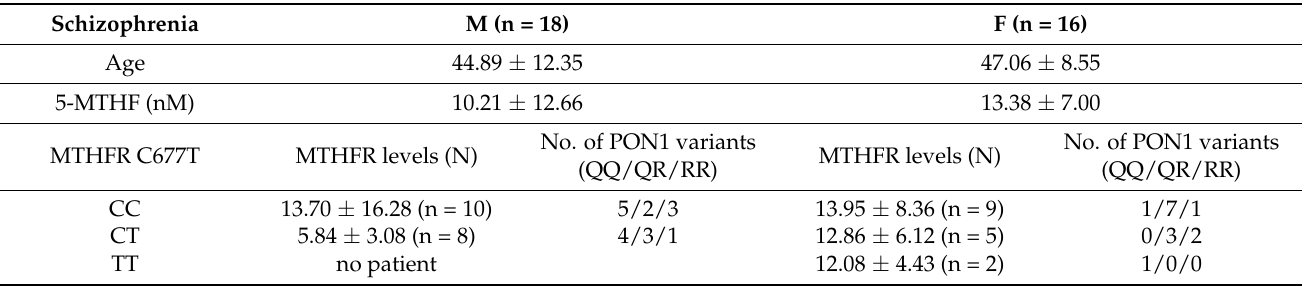
Table 5. Sex differences in 5-MTHF levels in healthy controls with different patterns of MTHFR C677T and PON1 variants.